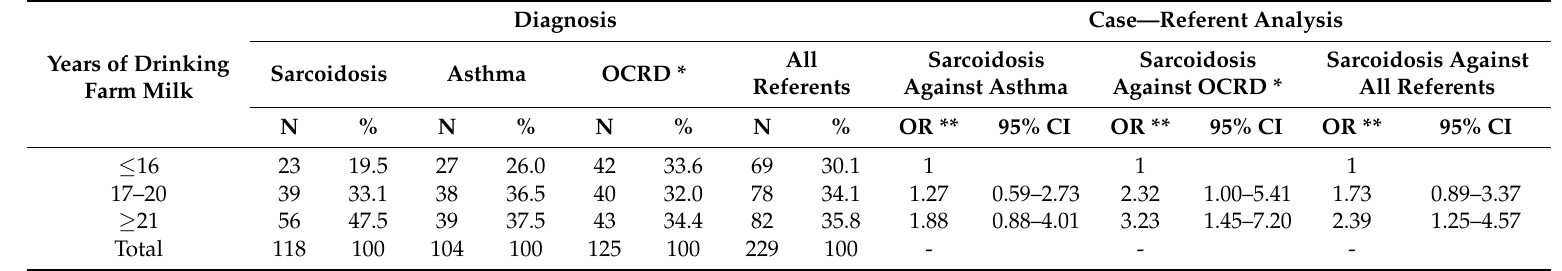
Table 4. Year of drinking farm milk comparing cases of sarcoidosis against referent groups: participants born into a family using farm milk and drinking farm milk for all years to age 5 years ( N =